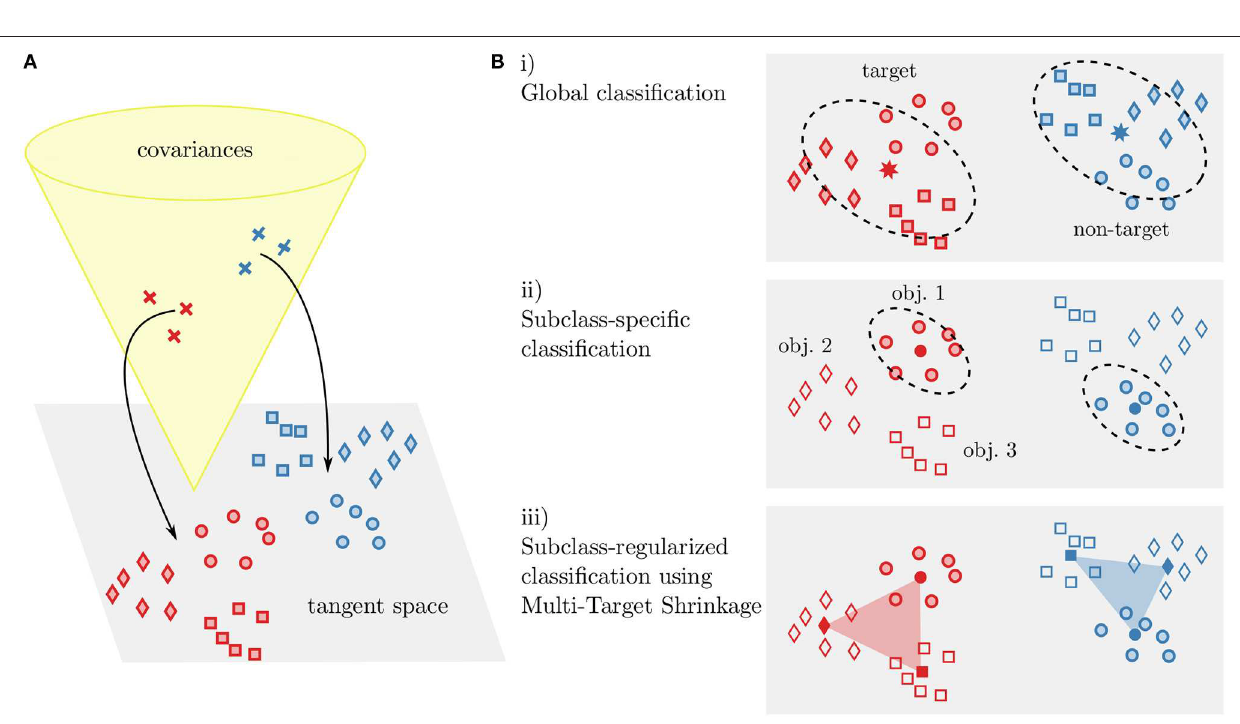
Frontiers in Robotics and AI |